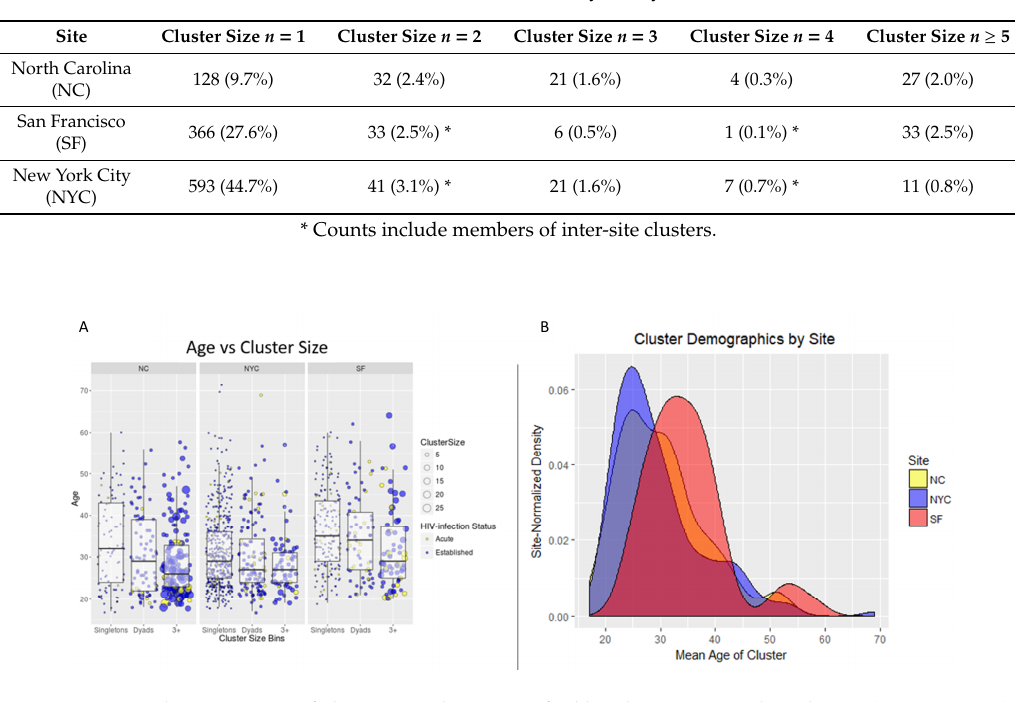
Figure 2. Age characteristics of cluster members, stratified by cluster size and study site (NC, SF, NYC). HIV transmission clusters varied with respect to size and the age of cluster members at the three study sites (North Carolina (NC), New York City (NYC), San Francisco (SF)). ( A ) Box-and-whisker plots of participant age, stratified by cluster size categories (singletons ( n = 1), dyads ( n = 2), and ≥ 3 (3 + )) and study site. Underplotted behind the box-and-whisker plots are circles representing each participant, where the y-axis position corresponds to their age and circle size corresponds to cluster size. Each circle is colored by the recency of HIV-infection (Acute or Established) and scaled according to the size of their respective transmission clusters. ( B ) Kernel density plots showing the average age for participants of each cluster on the x-axis, colored by study site. Please note that the NC plot is behind the SF and NYC plots and does not always appear yellow in color in overlapping plot